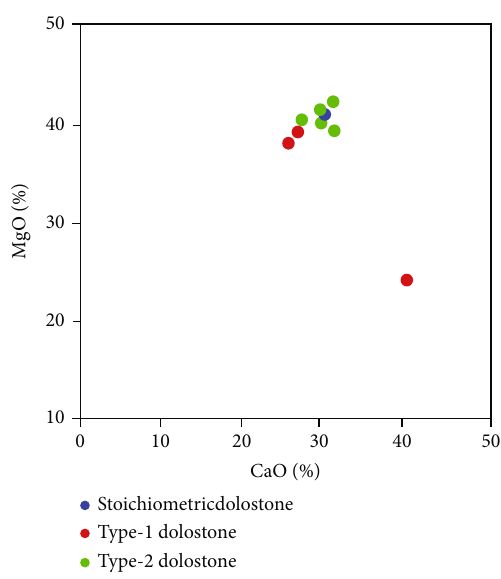
Figure 6: Dolostone compositions and distributions of CaO and MgO contents for submember Ma5 Formation in the northwestern Ordos